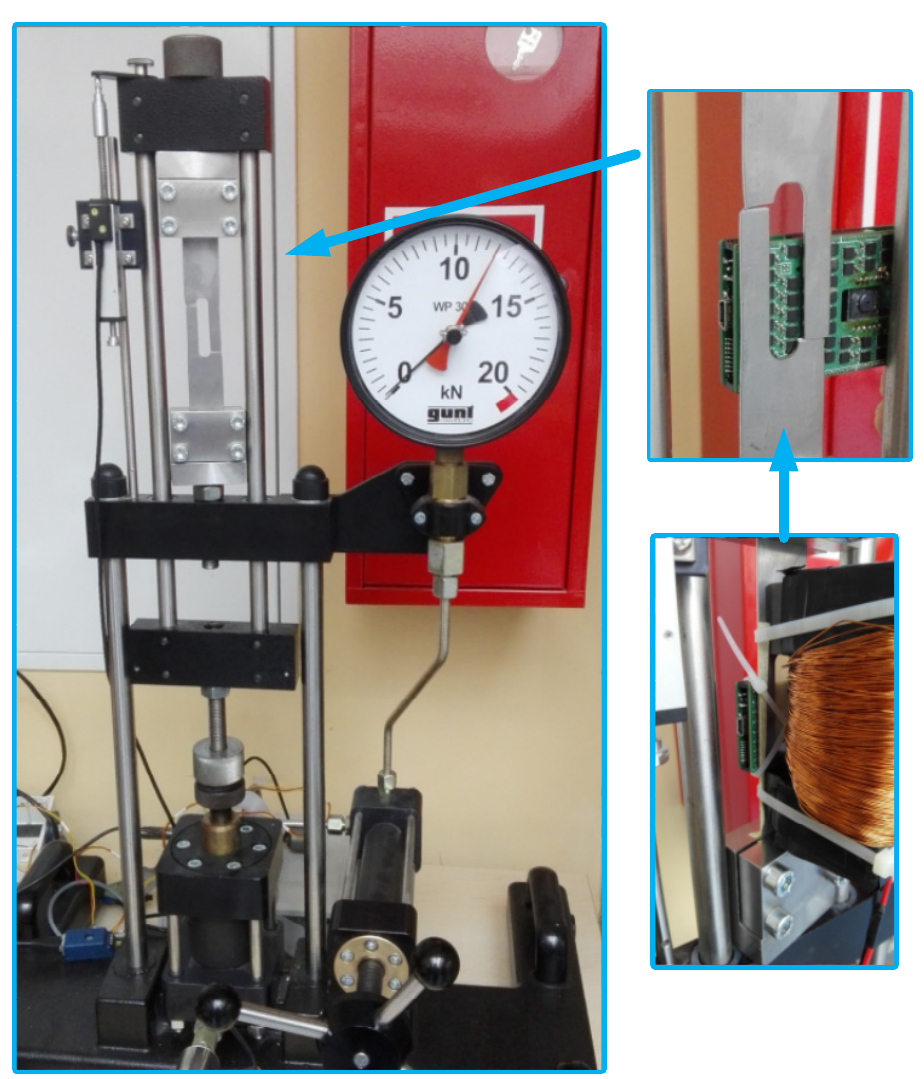
Figure 7. Mutual positions of the yoke, sample, and sensor matrix during the experiment.